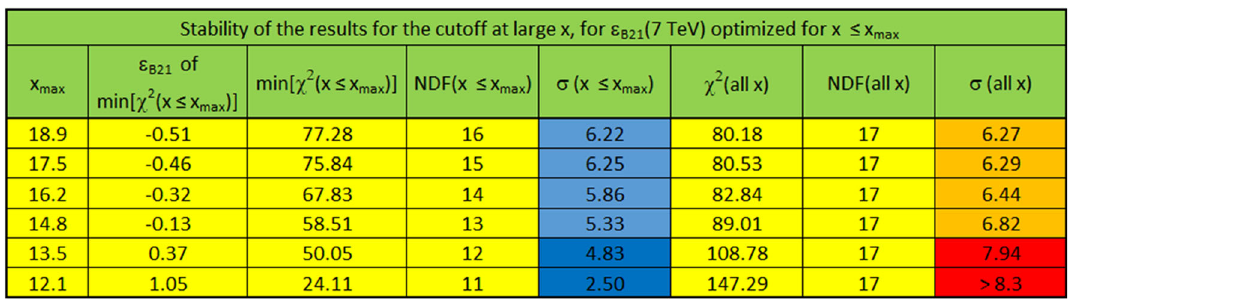
Table9 StabilityoftheOdderonsignalonthevariation x max ,theupper √ s = 7 TeV limit of the domain of validity of the H ( x ) scaling using √ s = 1 . 96 TeV D0 p ¯ p data in x = − tB , TOTEM pp data projected to for a fit range dependent, minimized correlation coefficient (cid:13) b , 21 , corre- spondingtotheminimumof χ 2 intheconsidered x -range.TheOdderon